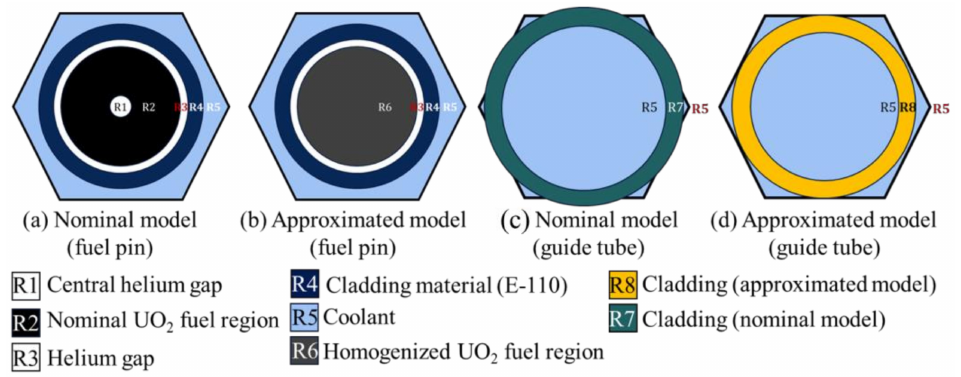
Figure 3. FA modeling approximation.